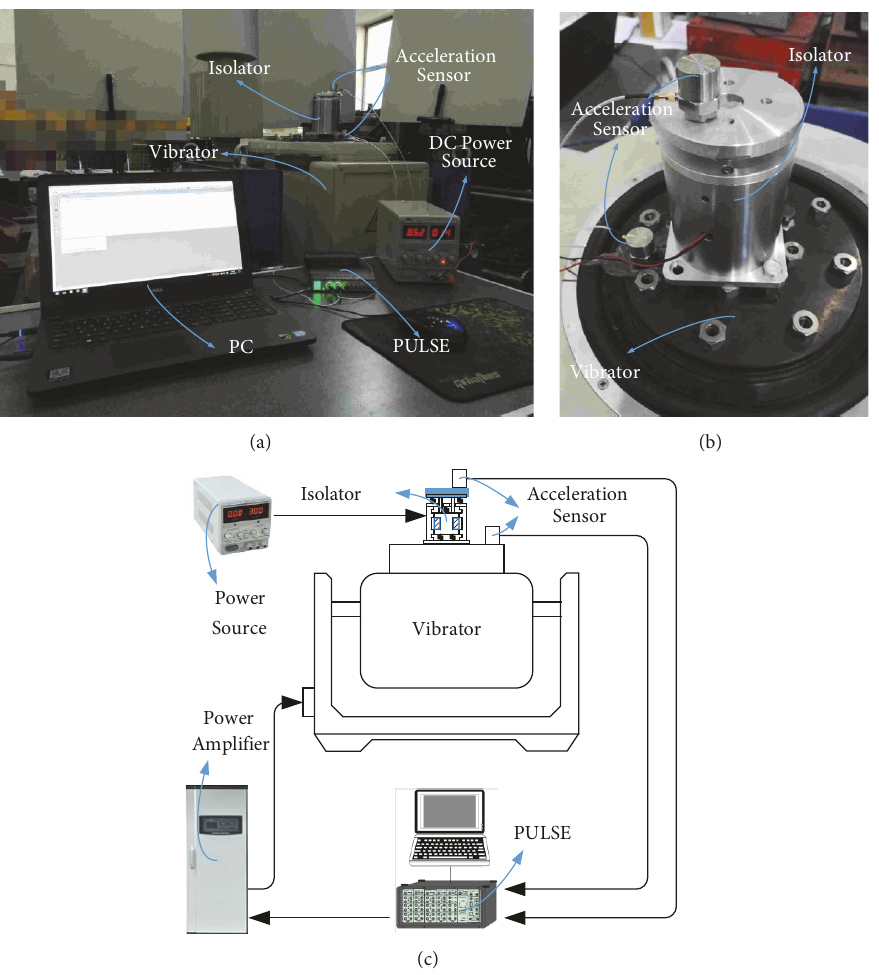
Figure 10: Experimental setup used in experimental tests: (a) primary equipment, (b) test rig, and (c) schematic diagram.